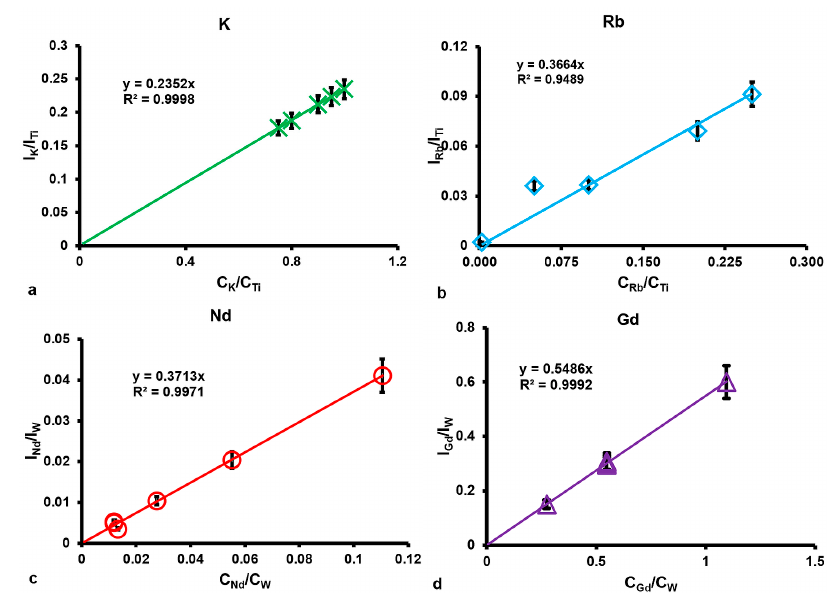
Figure 3. Calibration curves for K ( a ), Rb ( b ), Nd ( c ), and Gd ( d ); K and Rb were calibrated using the specimens presented in supplementary Table S1. Nd and Gd were calibrated using the specimens presented in supplementary Table S2 (K: 0.235x, R 2 = 0.9998; Rb: 0.366x, R 2 = 0.9489; Nd: 0.371x, R 2 = 0.9971; Gd: 0.549x, R 2 = 0.9992).